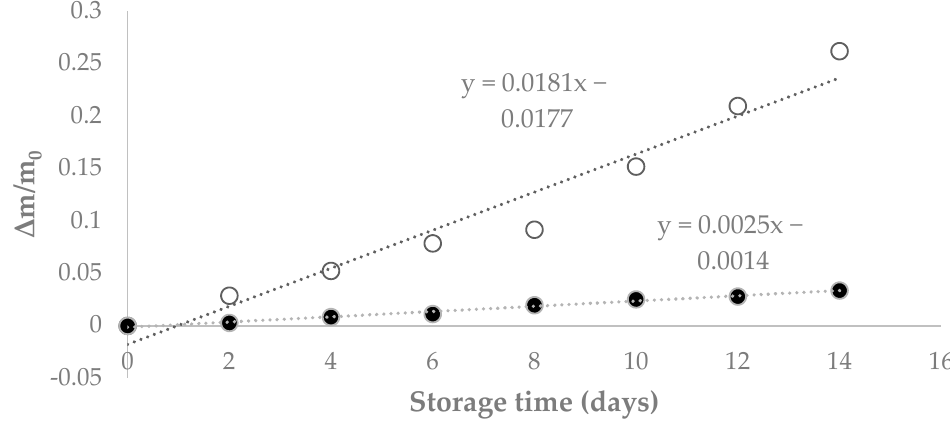
Figure 2. Weight loss of strawberries with ( ● ) and without ( ○ ) coating (F5 formulation) stored under 85% RH at 25 °C for two weeks.